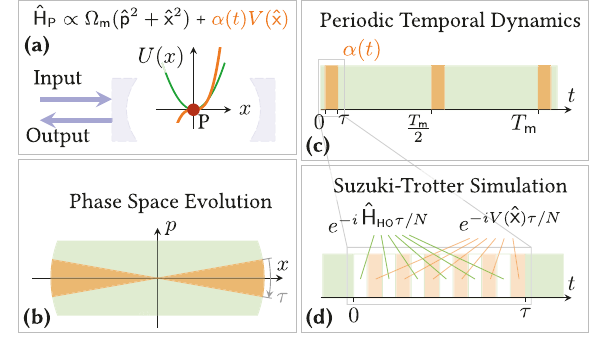
Fig. 1 Scheme of the proposed stroboscopic method. a A levitated optomechanical system as an illustration of mechanical oscillator in a nonlinear potential. A dielectric subwavelength particle (P) is trapped by a tweezer (not shown). The particle feels a total potential U ( x ) = Ω m x 2 /4 + α ( t ) V ( x ) that is a sum of the quadratic (green) and the nonlinear (orange, here: cubic) parts, both provided by the trapping beam. The particle can be placed inside a high- Q cavity and probed by the laser light. b , c Stroboscopic application of nonlinear potential. The nonlinear part of the potential is switched on for only a short fraction of the mechanical period (orange segments). The quadratic trapping potential (green segments) is present throughout all the evolution. d Suzuki-Trotter simulation of stroboscopic evolution of the mechanical mode. In the fi gure, orange segments represent action of the nonlinear potential, empty and fi lled green segments correspond, respectively, to unitary and damped harmonic